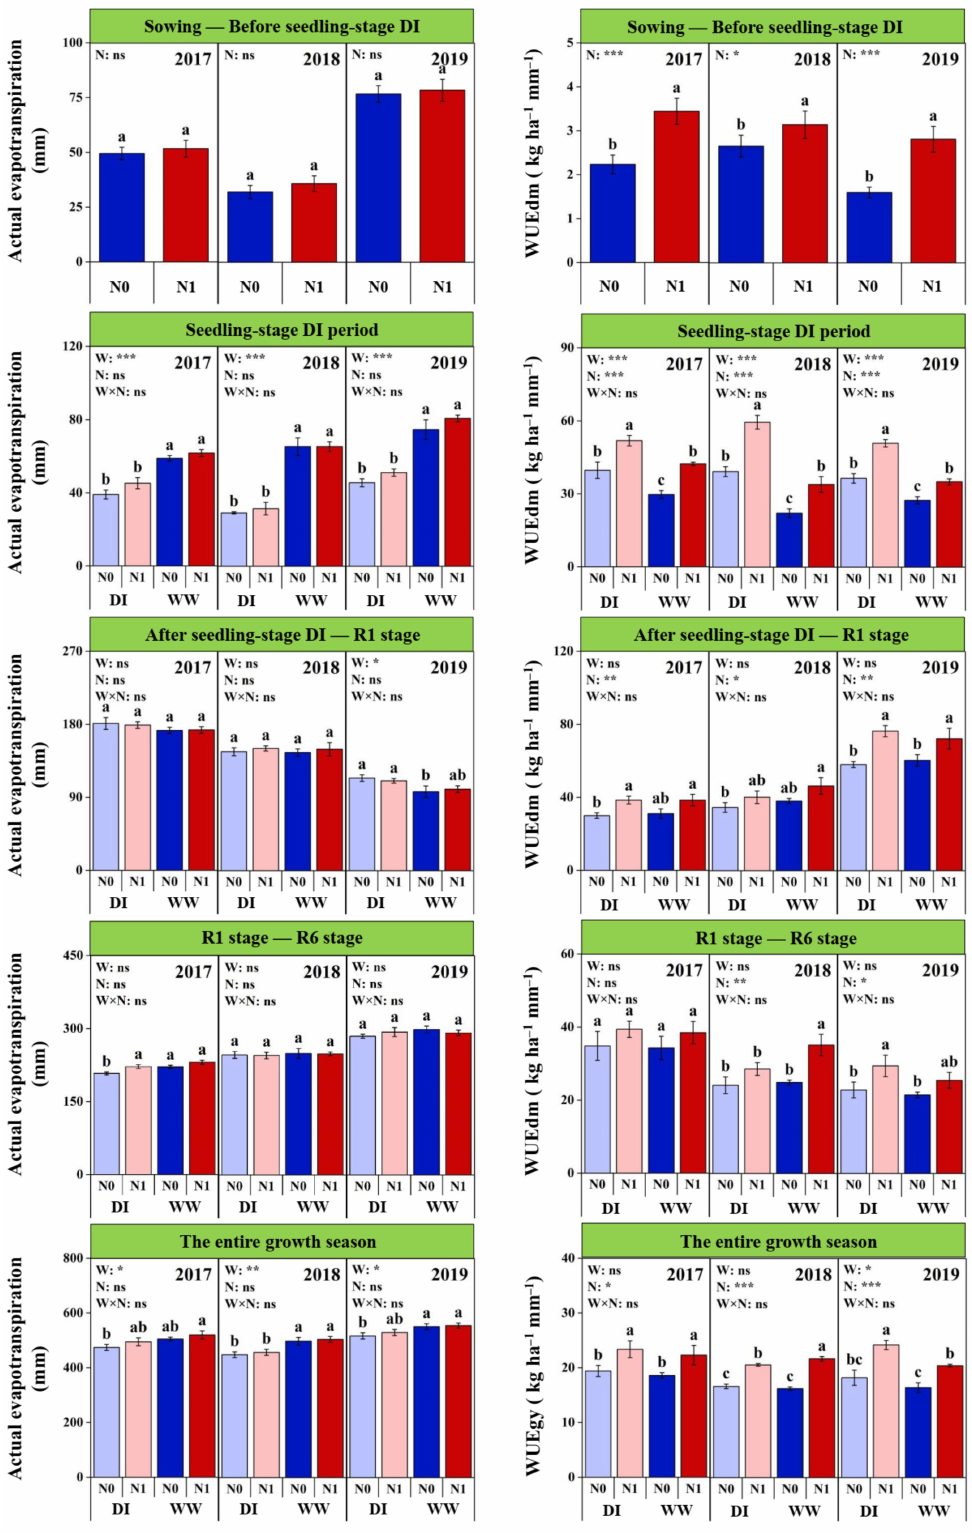
Figure 5. Effects of nitrogen fertilization (N) and seedling-stage water management regime (W) on actual evapotranspiration and water use efficiency for dry biomass (WUEdm) at different growth periods and grain yield (WUEgy) in 2017–2019. Note: *, ** and *** indicate significance at p < 0.05, p < 0.01 and p < 0.001, respectively, and ns indicates non-significance ( p > 0.05). Different letters above bars indicate significant differences between treatments ( p <